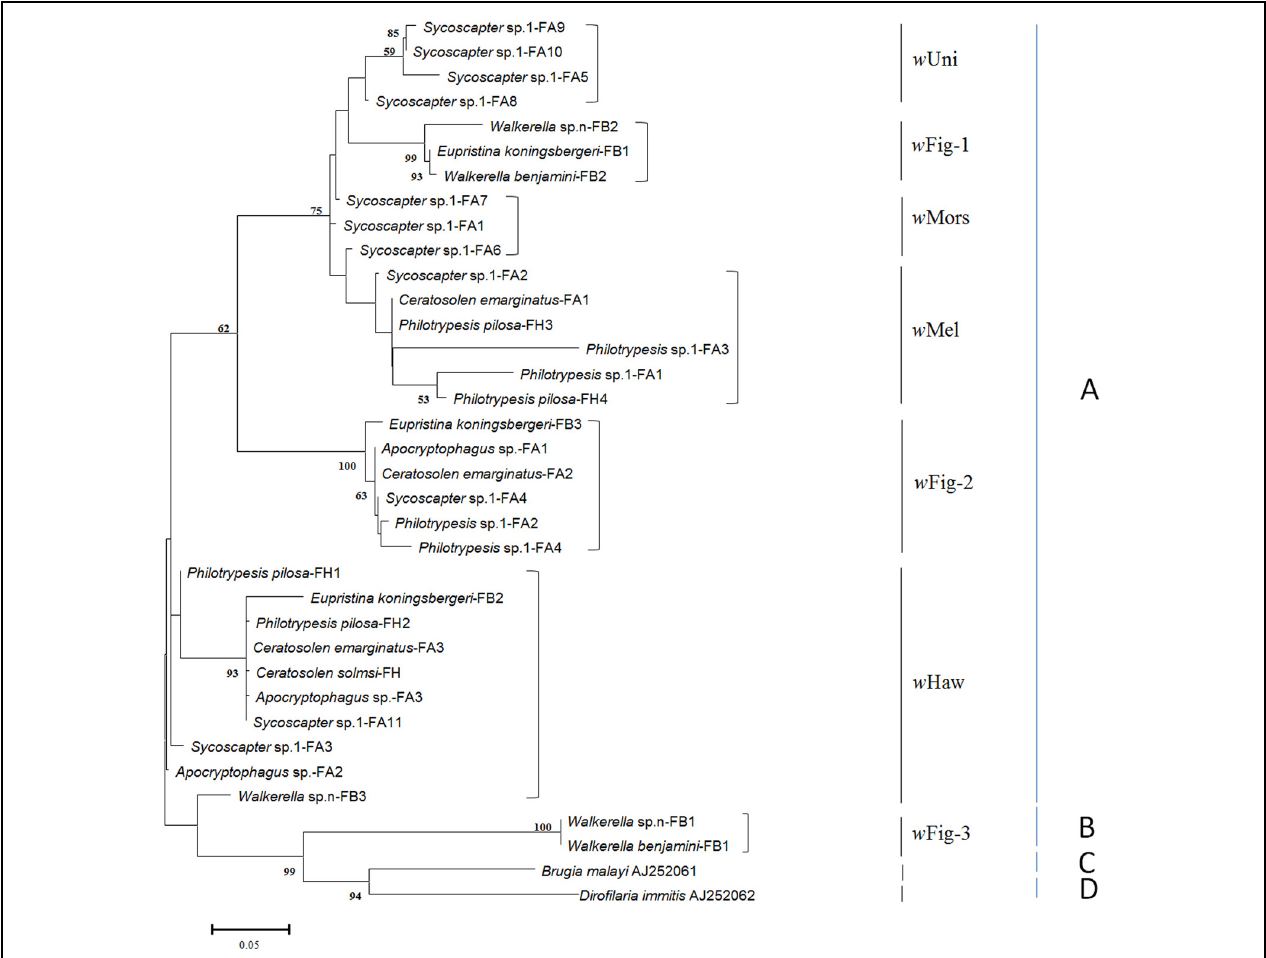
FIGURE 1 | ML tree constructed with wsp sequences from fig wasps. Two sequences from supergroup C and D are used as outgroups. The supergroups (A–D) are listed on the right, while the strains previously reported and newly found are also indicated. Each OUT is named as its insect host (fig wasp) name followed by the fig name (FA: Ficus auriculata, FH: Ficus hispida , and FB: Ficus benjamina ), and the numbers at last mean different haplotypes of wsp